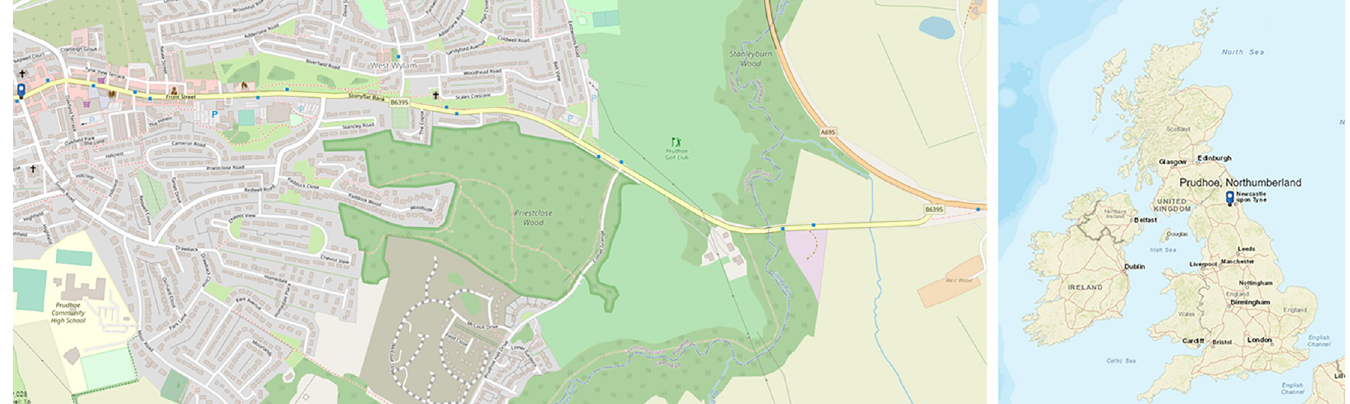
Fig 1. Location of (a) Priestclose Wood, and (b) Prudhoe, Northumberland, UK. [USGS National Map Viewer; USGS National Map Viewer]